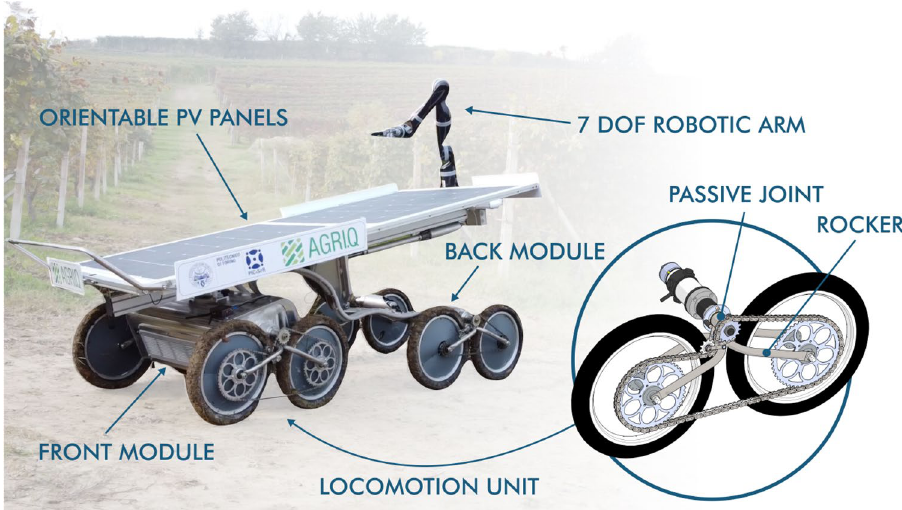
Fig. 1 Agri.Q in a vineyard in Castagnito, part of the Roero historical region in the south of the Italian region